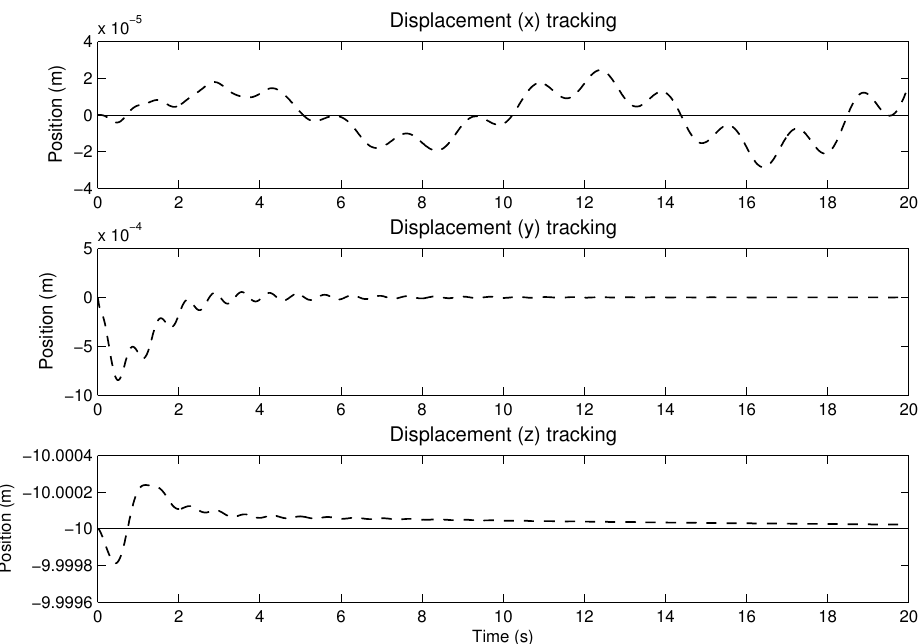
Figure 4. The nonlinear rotorcraft model response to selected trim control